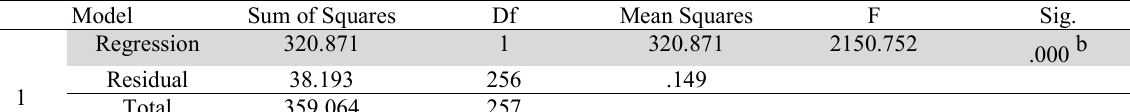
Model 1 regression – ANOVA a